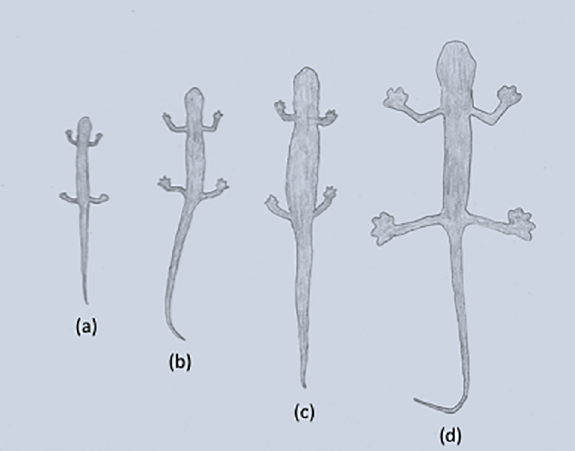
Fig 13. Relative size differences. Silhouette drawings illustrating the size differences among the four species of Chiropterotriton examined in this study. Rendered from a single photograph of the dorsal view of adult preserved specimens. (a) C . dimidiatus (MVZ 114511; SVL = 25 mm, total length = 50 mm); (b) C . lavae (MVZ 171876; SVL = 34 mm, total length = 69 mm); (c) C . priscus (MVZ 138885; SVL = 46 mm, total length = 86 mm); (d) C . magnipes (MVZ 129016; SVL = 52 mm, total length = 108 mm). doi:10.1371/journal.pone.0127248.g013 When the frontals and parietals fail to meet along their medial borders, an opening in the skull roof results. This frontoparietal fontanelle is most pronounced in paedomorphic salaman- ders such as Batrachoseps [27] and Thorius [16]. None of the Chiropterotriton species exam- ined here show frontoparietal fontanelles as large as members of those genera, but variation is evident (Table 2, Figs 2A – 5A and 10). The fontanelle is relatively extensive in all C . dimidiatus as well as in a few (30%) C . priscus . The remainder of C . priscus show a reduced opening, as do all C . lavae . The most extensive development of the frontals and parietals is found in C . mag- nipes , in which obliteration of the fontanelle is found in 70% of the specimens examined. Several bony processes were observed to project from the posterior region of many of the skulls examined (Table 2). The most unusual of these structures was seen in half of the C . mag- nipes specimens. In these animals, a flat, posterodorsally projecting, tab-like process was seen to emerge from each parietal at a level just anterior to the articulation with the otic capsule (Fig 2A). These processes were present in various states of development, from only slightly raised ridges to well-developed, quadrangular tabs. Three of the five animals possessing this structure Table 5. Frequency (%) of right-left asymmetry in paired osteological characters. Species